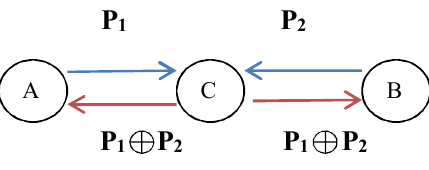
Fig. 1. An example of network